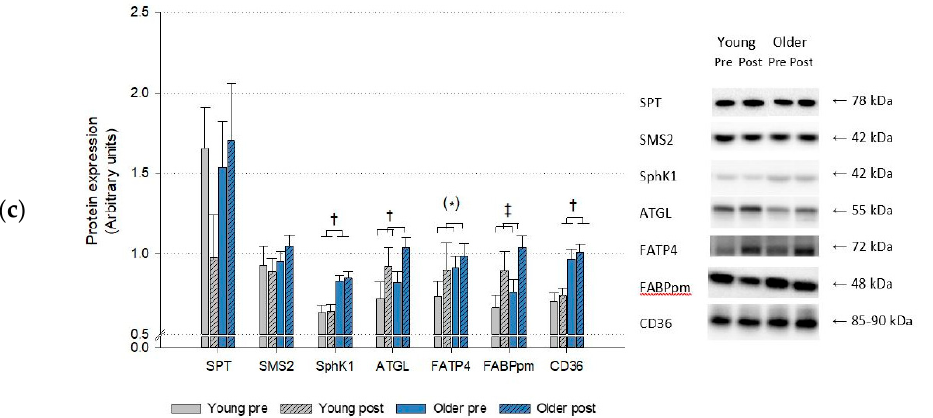
Figure 3. Protein expression in muscle of young and older subjects measured before and after 6 weeks high-intensity interval training. Expression of proteins involved in ( a ) glucose transport and metabolism, ( b ) insulin signalling and ( c ) ceramide and diacylglycerol (DAG) metabolism and lipid transport. Age and training effects: * p < 0.05, † p < 0.01, ‡ p < 0.001. Borderline significance: (*) p < 0.1. Young: n = 13, older: n = 21. Data are means ± SEM. AKT ser473 : AKT phosphorylated at ser 473 , ATGL: Adipose triglyceride lipase, CD36: Cluster of differentiation 36, FABPpm: Fatty acid binding protein plasma membrane, FATP4: Fatty acid transport protein, GS: Glycogen synthase, GP: Glycogen phosphorylase, HKII: Hexokinase II, PKC θ : Protein kinase C θ , PKC θ ser676 : PKC θ phosphorylated at ser 676 , PP2A: Protein phosphatase 2A, SMS2: Sphingomyelin synthase 2, SphK1: Sphingosine kinase 1, SPT: Serine palmitoyl transferase, SNAP23: Synaptosome associated protein 23.